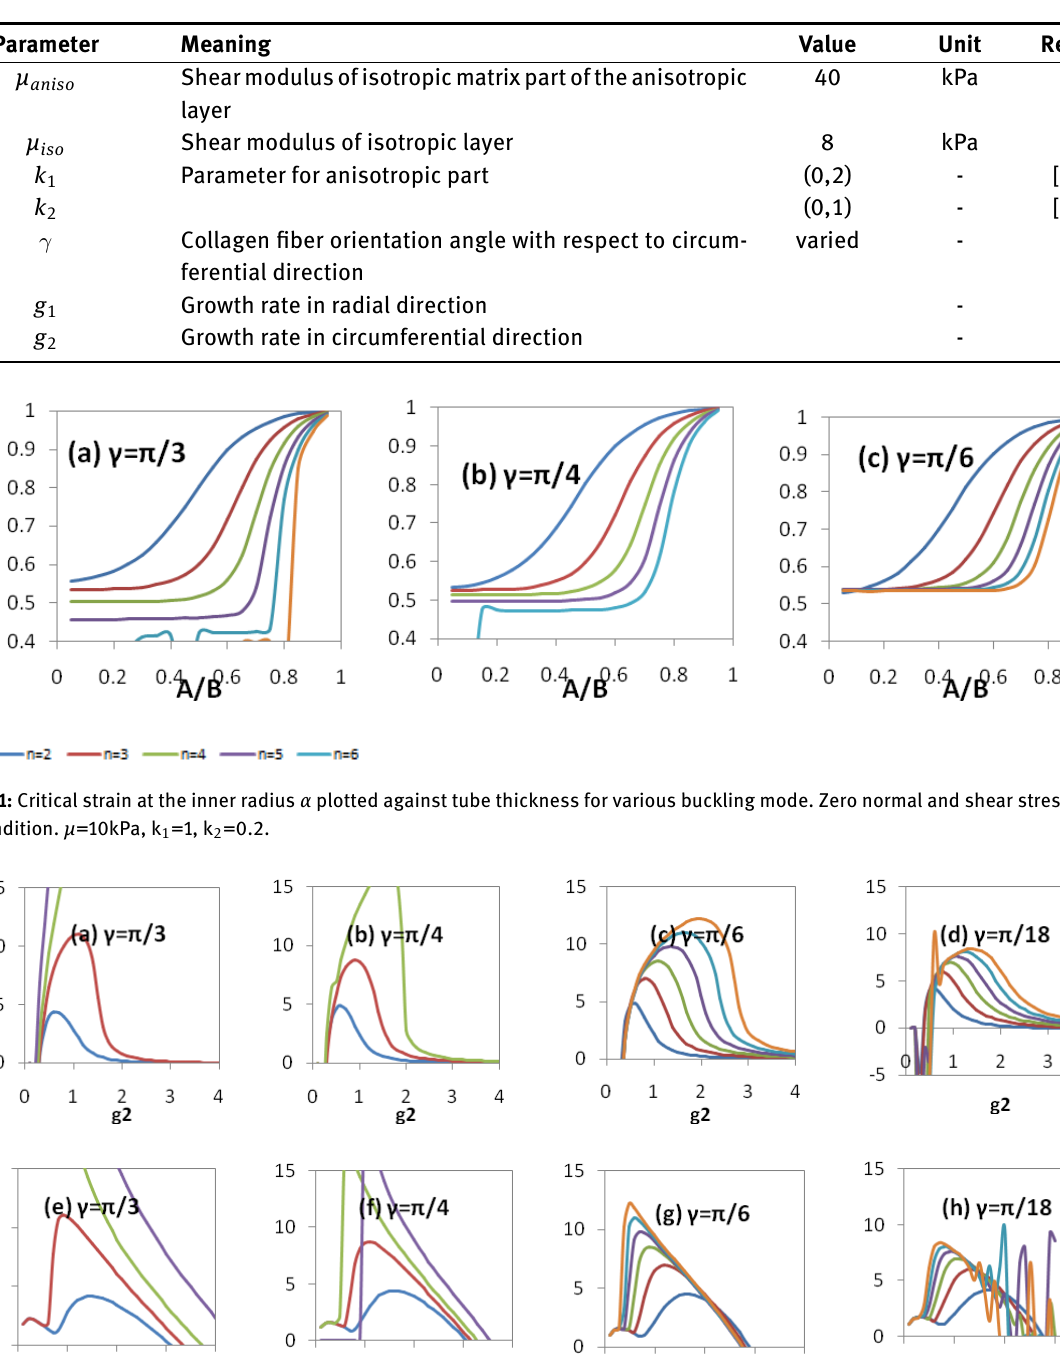
Table 1: Default parameter values.